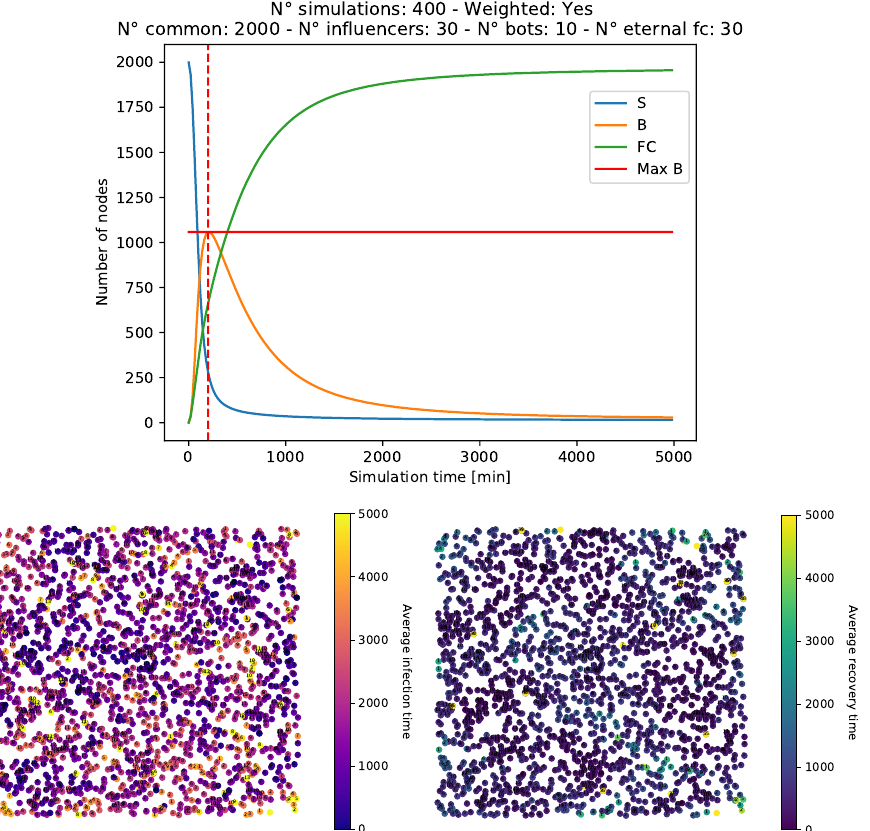
Figure 8. SBFC plot, network infection, and recovery graphs for the same networks of Figure 5, but with the addition of eternal fact-checkers and weights on the